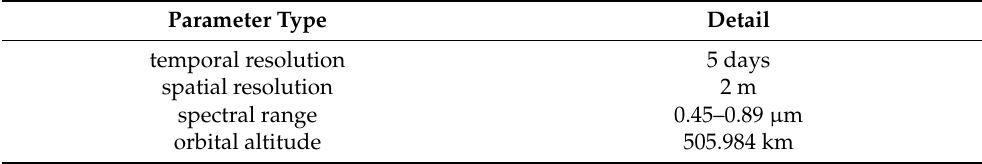
Table 1. Detail information for ZY-3 satellite